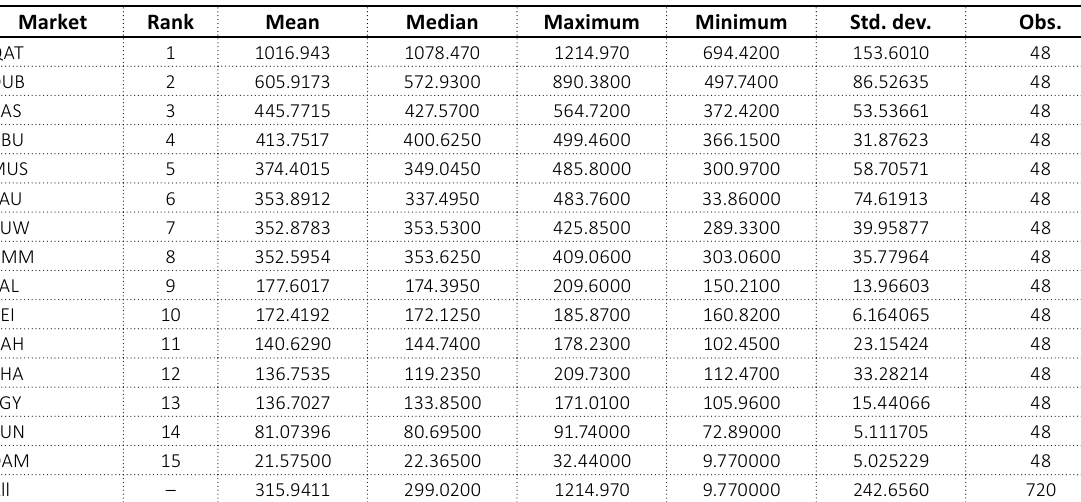
Table 1. Summary statistics of monthly prices of stock market indices,